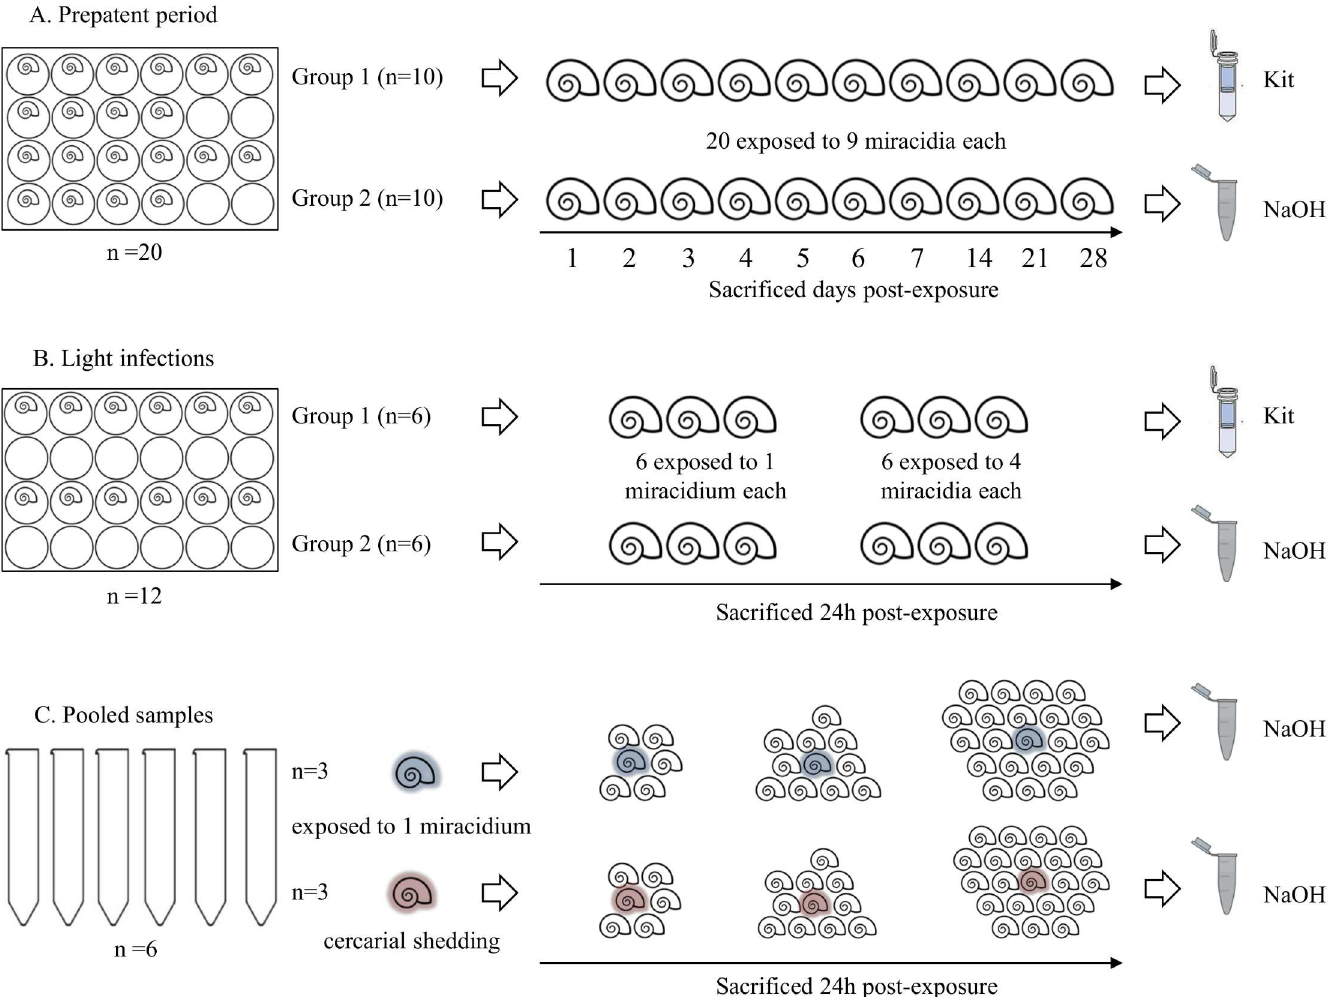
Fig 1. Scheme of experimentally infected snails in this study. (A) Prepatent period. (B) Light infections. (C) Pooledsamples. Kit and NaOH, indicate the commercialkit or the heat NaOH extraction method for DNA obtaining,respectively. Number or snails used in each infection, expositionof snails to miracidium/miracidia, snails showingcercarial sheddingand sacrificeddays post-exposure are indicatedby a text in figure.